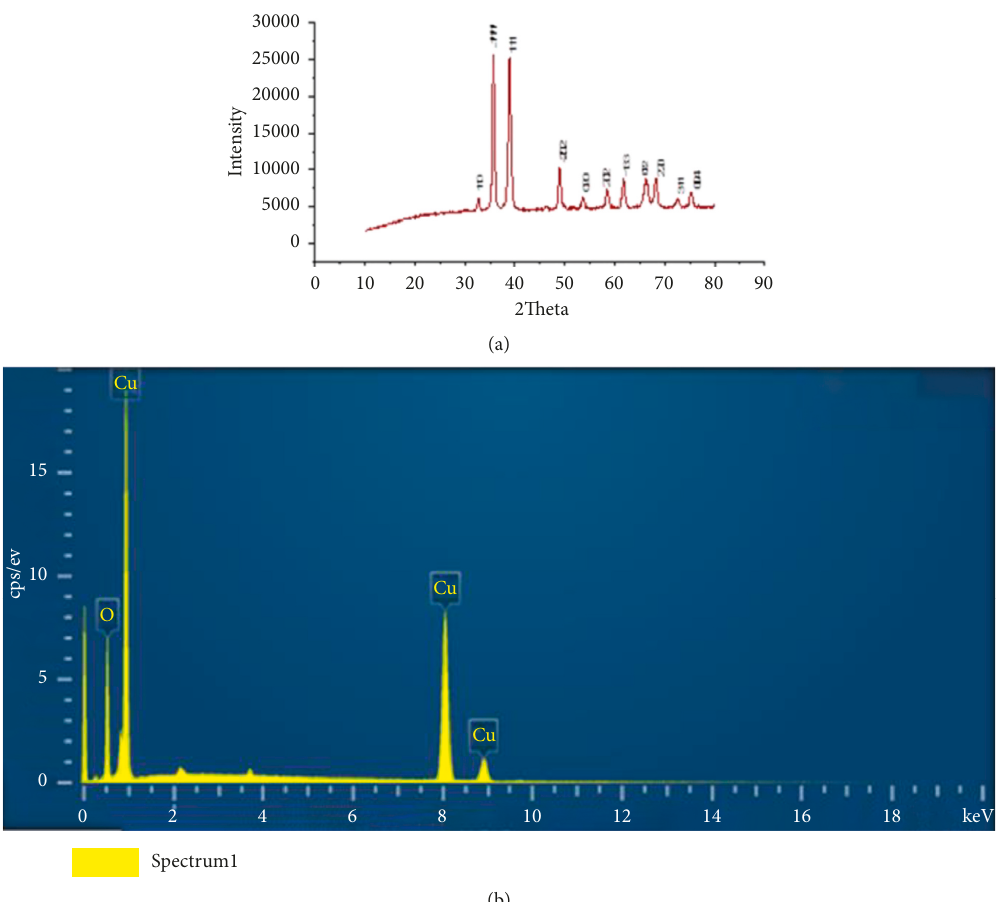
Figure 1: X-ray diffraction (XRD) (a) and energy dispersive X-ray spectroscopy (EDX) (b) of CuO NPs with the presence of the elemental compositions of copper and